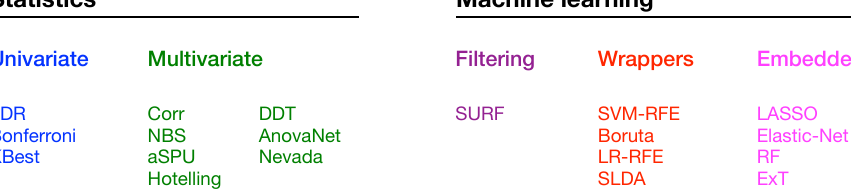
Figure 1. List of the 19 selection methods here considered, classified according to their nature. For the sake of clarity, the same class colour code will be used in all subsequent